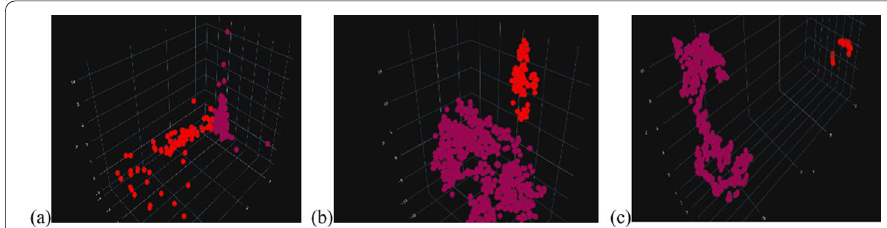
Fig. 8 The performance of different dimensional reduction algorithms on credit card fraud dataset. Feature size is reduced to dimension 3 by a PCA, b t-SNE and c